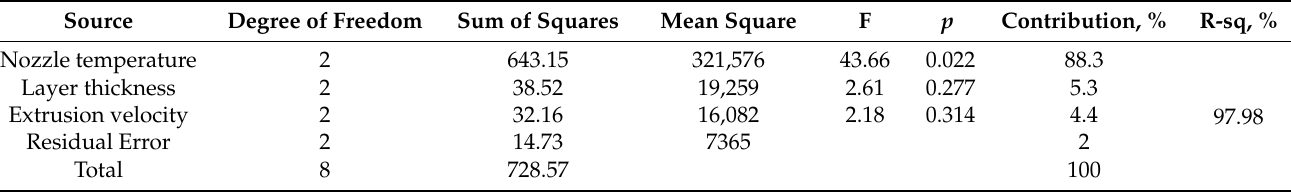
Table 7. ANOVA results for part’s width accuracy.